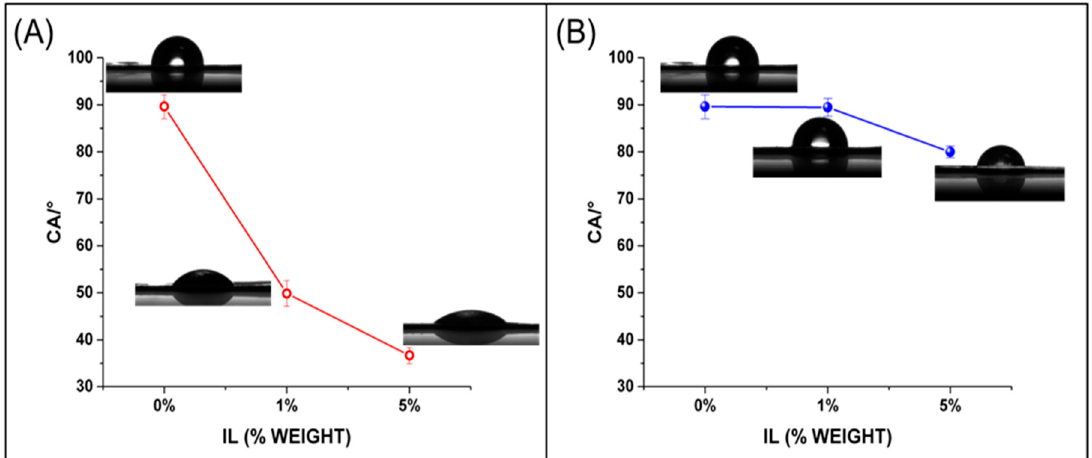
Figure 5. Water contact angles for Pebax ® Rnew and Pebax ® Rnew / ILs blends. ( A ) IL1 blends and ( B ) IL2 blends.